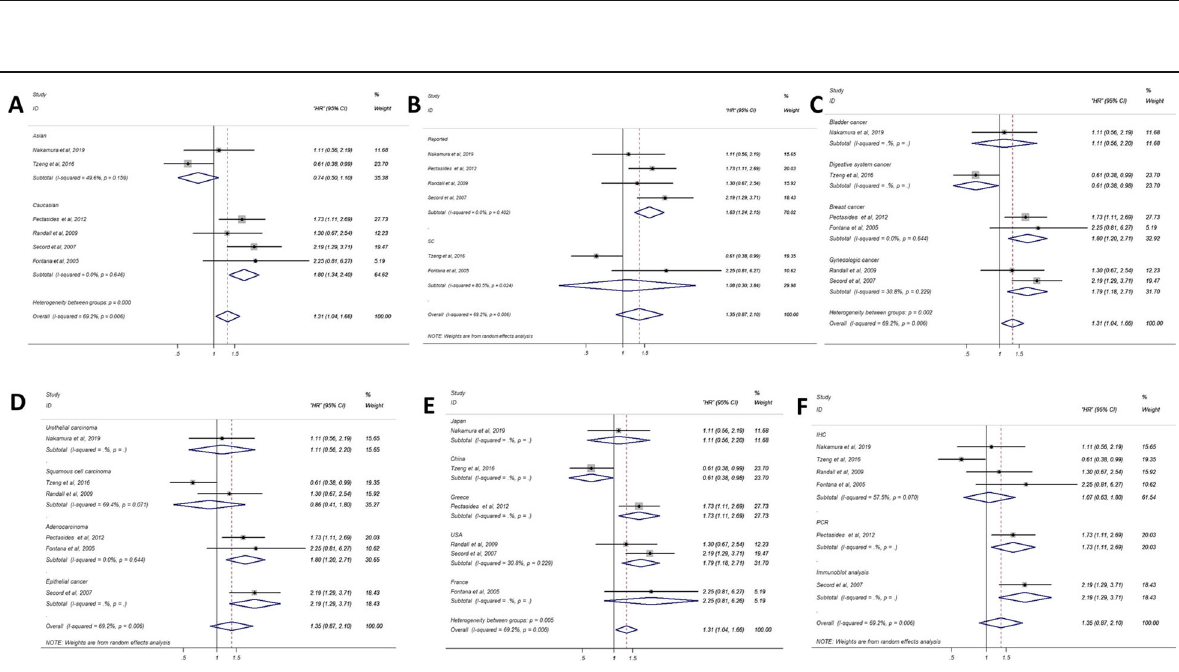
Fig. 4 Forest plots of merged analyses for PFS/MFS associated with TSP-1 expression. (A) Forest plots for the subgroup analysis in different ethnicities; (B) Subgroup analysis in different source of HR; (C) Subgroup analysis in different disease types; (D) Subgroup analysis in different pathological types; (E) Subgroup analysis in different nationalities; (F) Subgroup analysis in different assay methods. Abbreviations: HR, Hazard ratio; SC: survival curve; PCR, polymerase chain reaction; IHC,